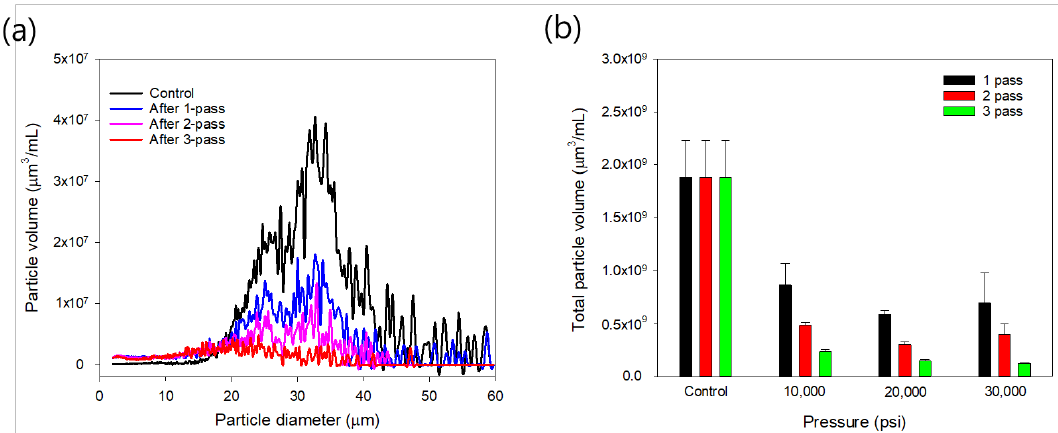
Figure 3. Changes in volume distribution ( a ) and total volume ( b ) of H. pluvialis bio-particles after mechanical disruptions with different pressures and passes. The bio-particles refer to all internal components as well as intact, leaky, and ruptured cyst cells. Representative particle-size-volume distributions after the 10,000 psi-homogenizations at three different passes were presented based on the Coulter counter analysis. Total volumes were calculated by summing each volume of all particles sized between 15 and 60 µm.